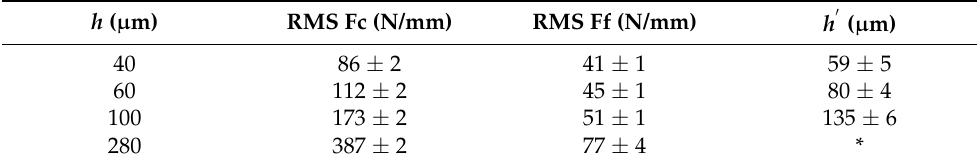
Table 3. Forces and chip thickness measured from experiments for h = 40 µ m, 60 µ m and 100 µ m [32].